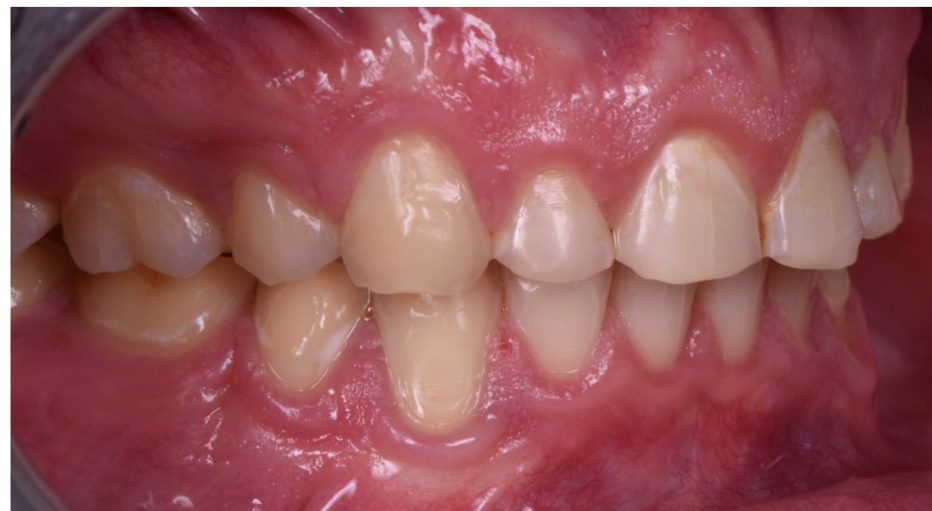
Figure 6. Intraoral picture